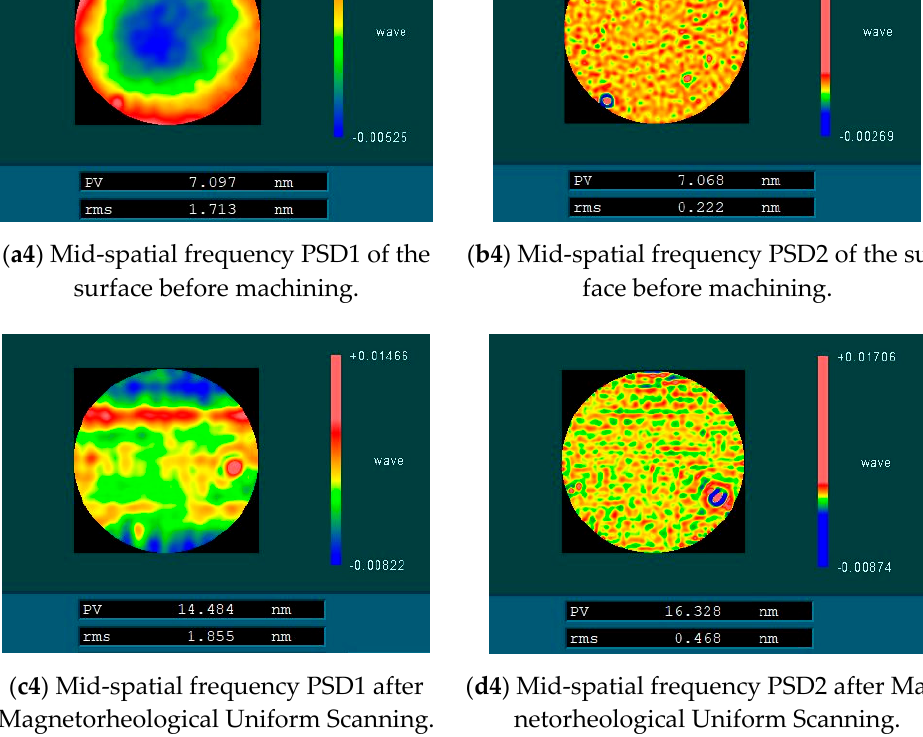
Figure 16. Mid-spatial frequency error before and after magnetorheological processing.